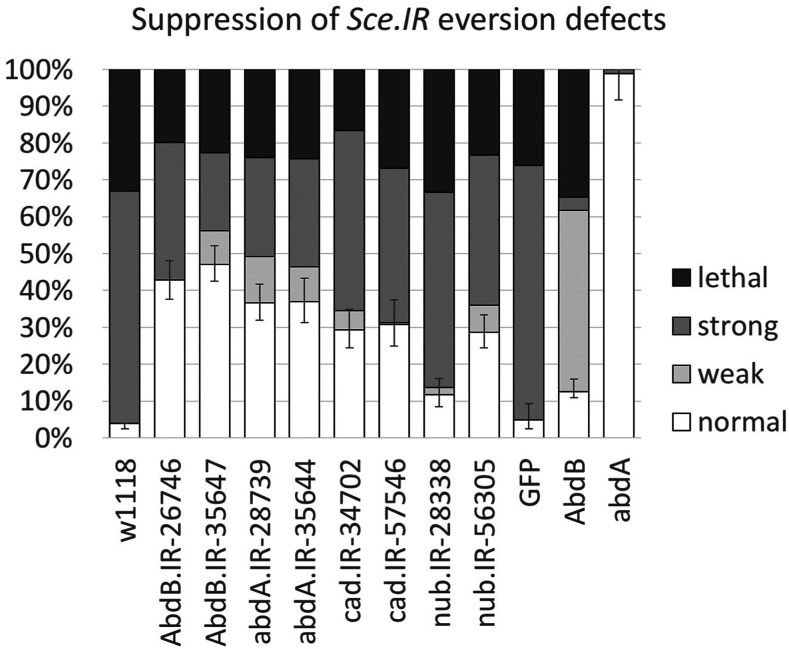
Knockdown of de-repressed loci substantially represses Sce.IR eversion phenotypes. Effects on adult eversion failure when Ubx-GAL4 knockdown of Sce is accompanied by expression of the indicated UAS RNAi lines, or UAS-GFP control. Co-expression of GFP does not significantly decrease the rates of eversion failure in Ubx > Sce.IR discs, but co-expression of UAS RNAi lines for Abd-B, abd-A, cad, and nub all repress eversion failure. Ubx-GAL4 expression of Abd-Bm produces a high proportion of weak phenotypes in which the thorax is normal, but wings are deformed or mispositioned (56%, n = 222). Expression of abd-A has no effect (n = 84). Error bars = 95% confidence interval (Wilson score method).